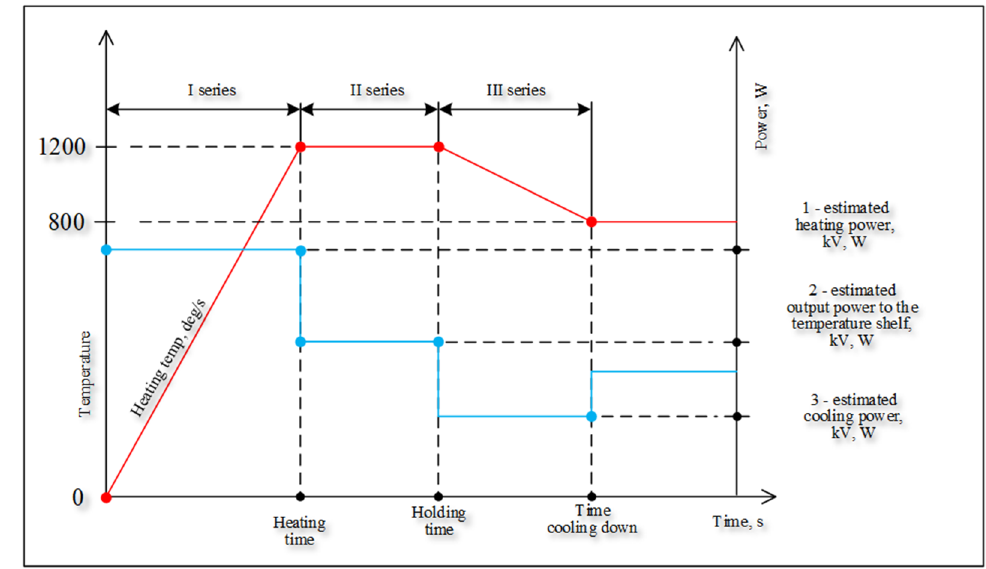
Figure 4. Heating diagram using IAS.